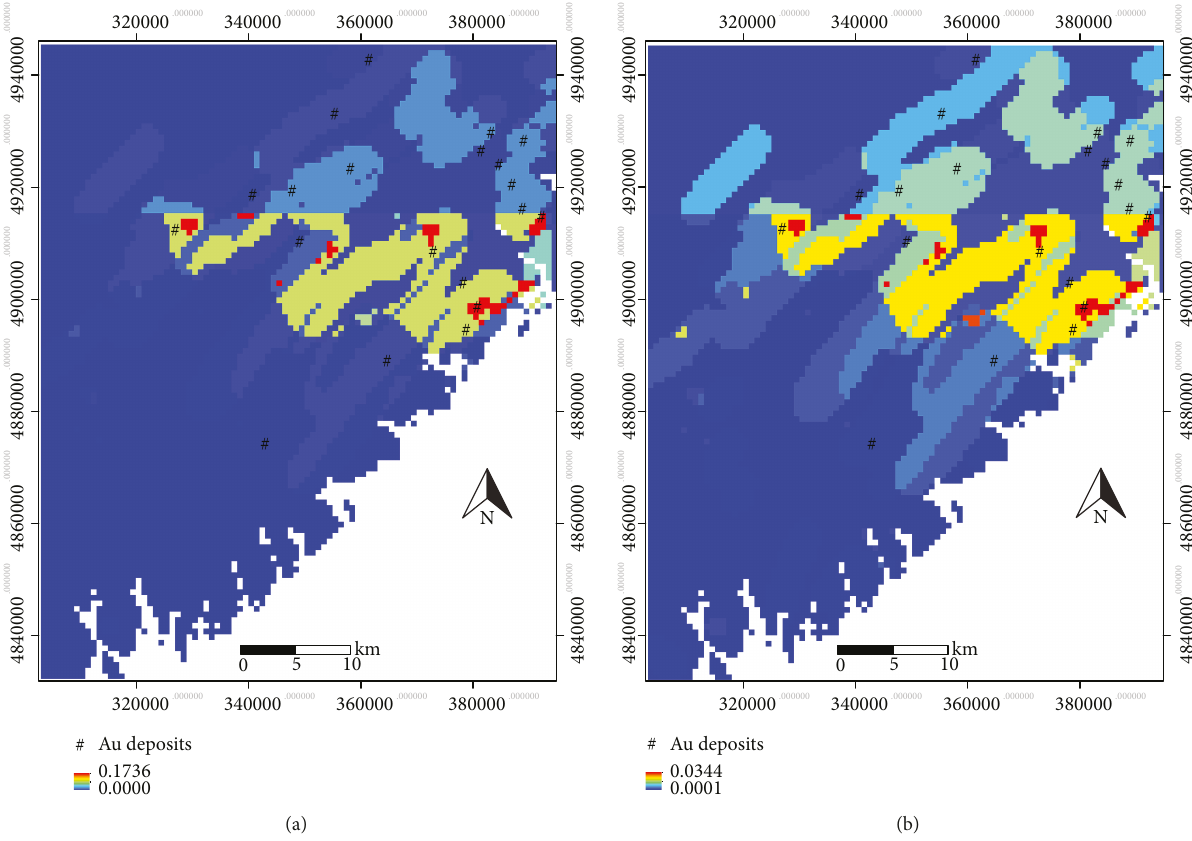
Figure 7: Posterior probability maps obtained by (a) weights of evidence and (b) modi fi ed weights of evidence in experiment